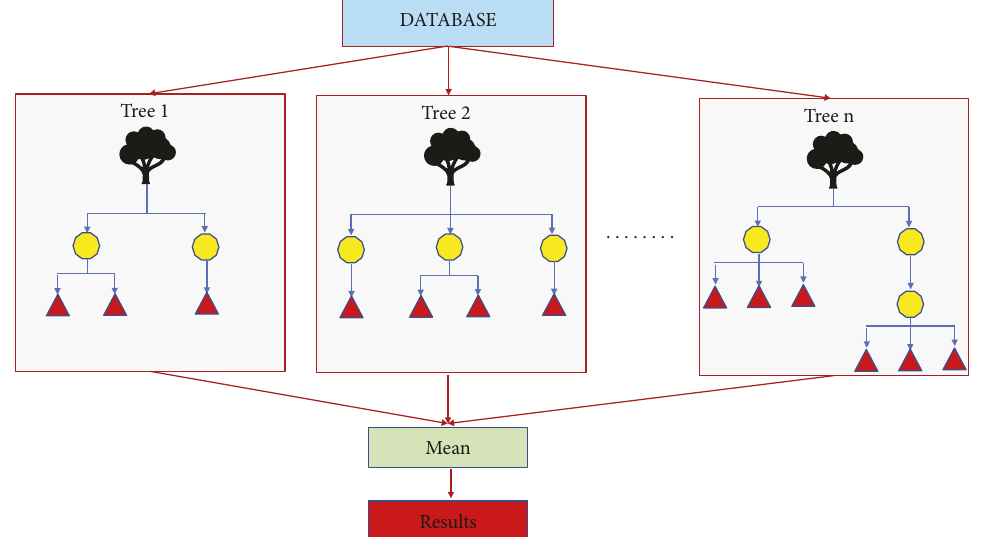
Figure 5: Ensemble decision trees